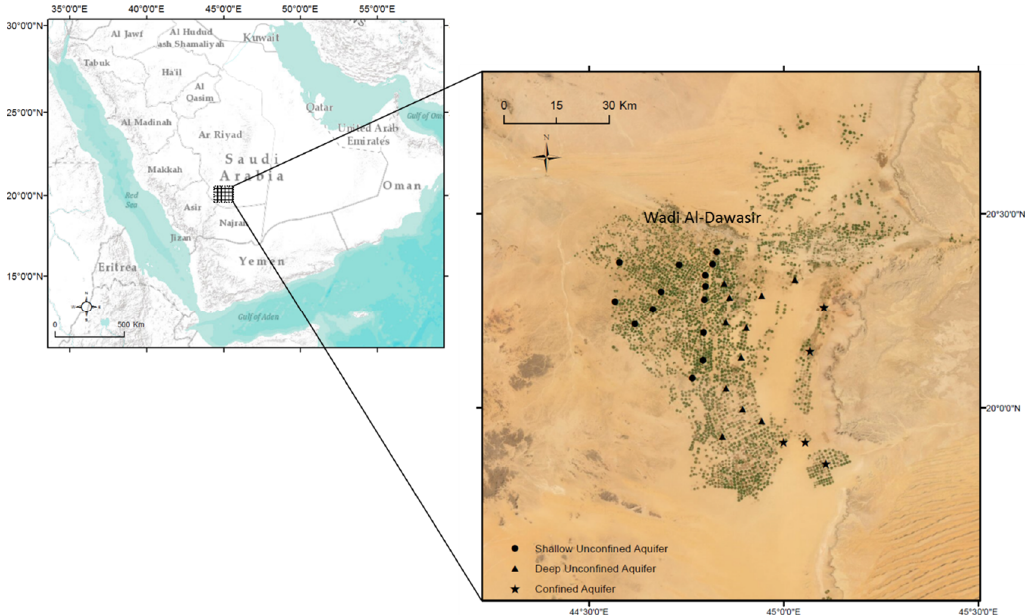
Figure 1. Location map shows the groundwater samples from unconfined and confined parts of the Wajid aquifer in Wadi Al-Dasawir, southern Saudi Arabia.